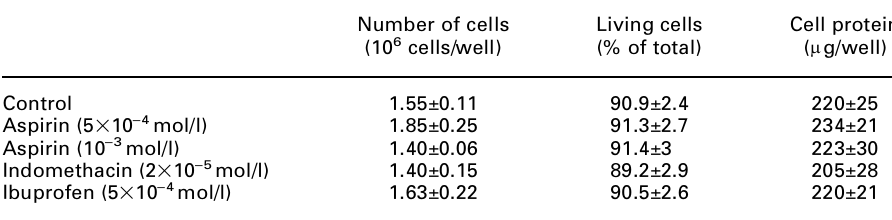
Table 1. Effects on NSAIDs on cell